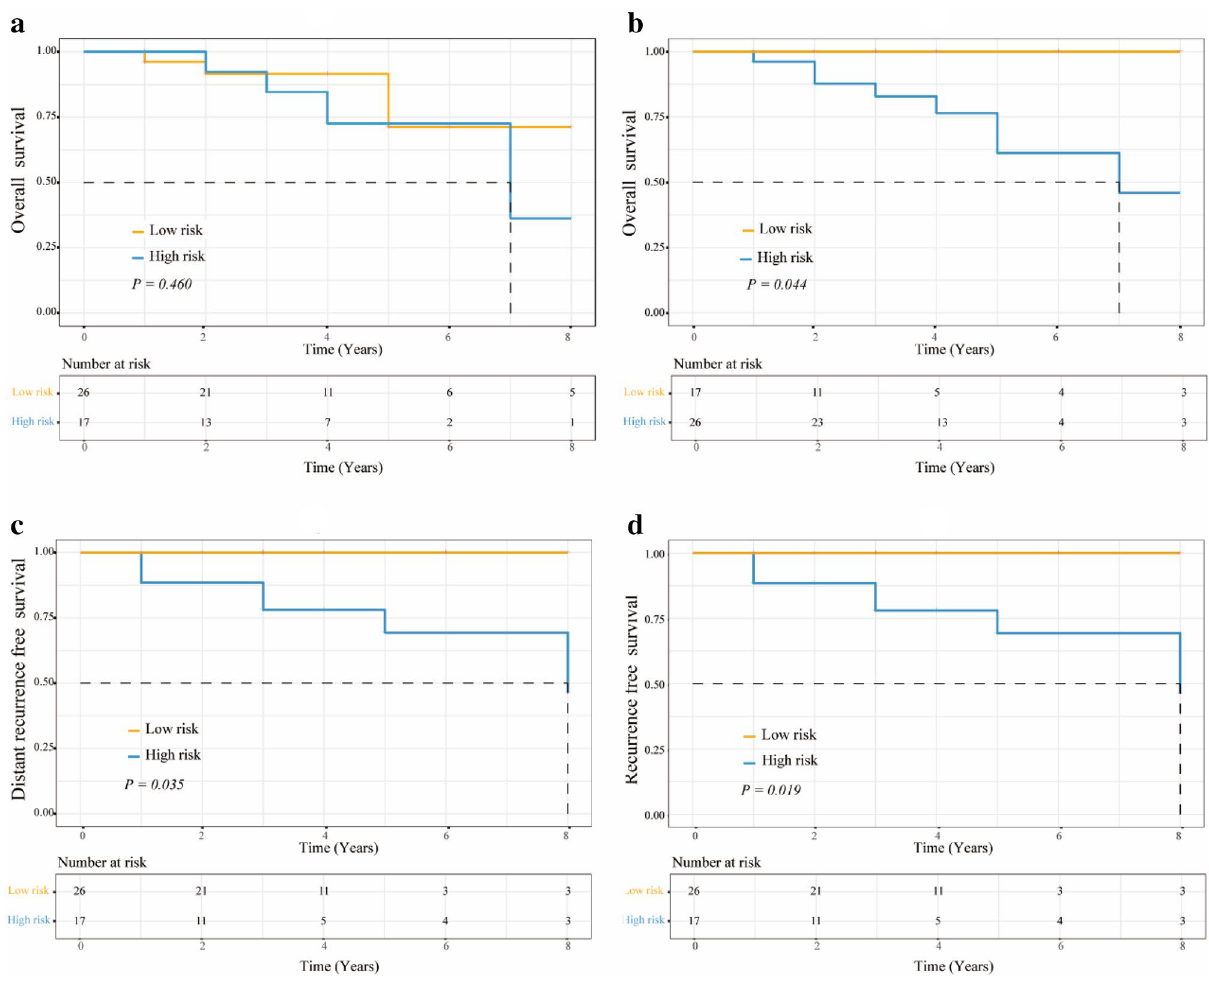
Figure 1. Comparison on the survival curves of low- and high-risk patients stratified by RI-LR and RI-DR. ( a ) Overall survival of low- and high-risk patients identified by RI-LR; ( b ) Overall survival of low- and high-risk patients identified by RI-DR; ( c ) Distant recurrence-free survival of low- and high-risk patients identified by RI-DR; ( d ) Progression-free survival of low- and high-risk patients identified by